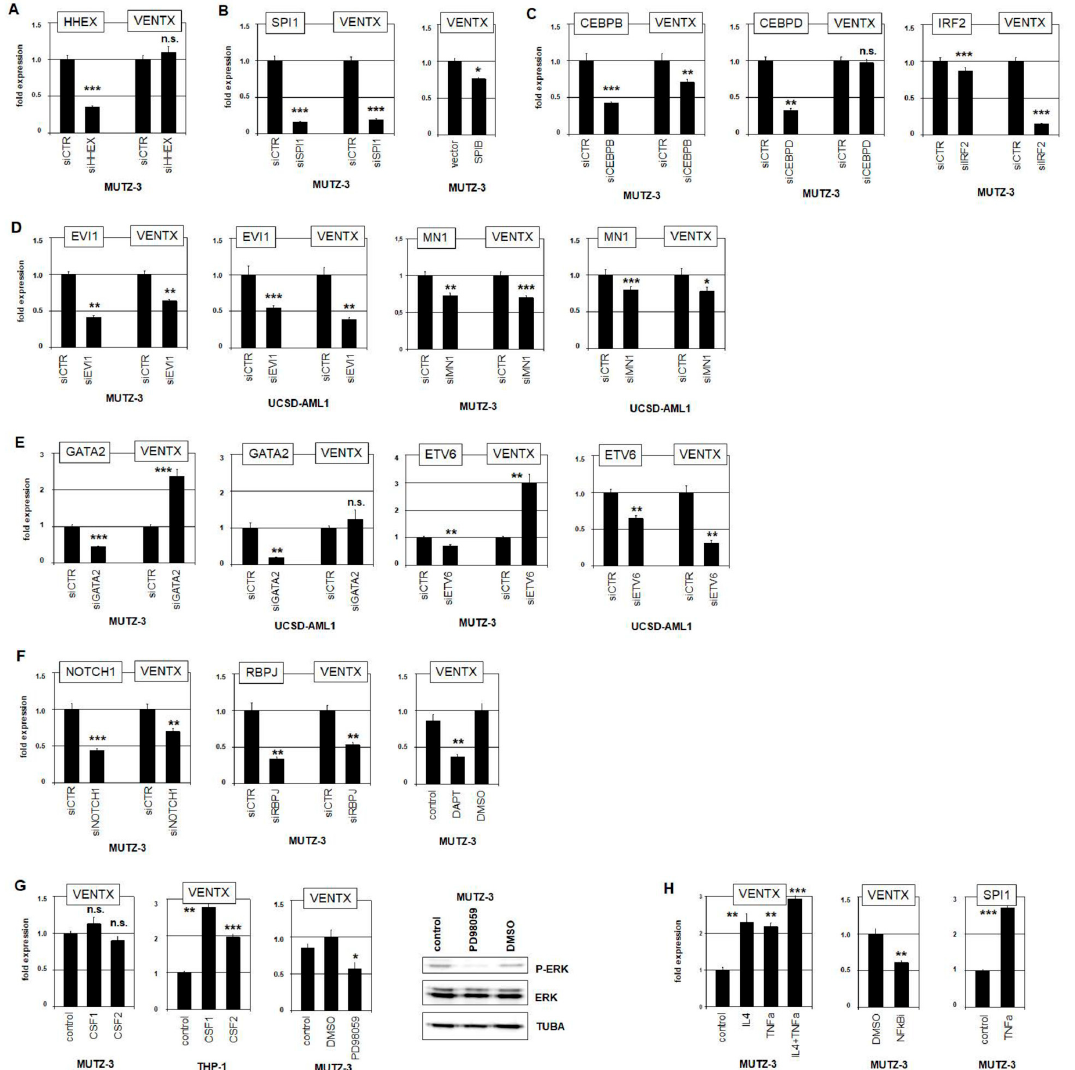
Figure 5. Evaluation of VENTX regulators. To evaluate identified candidate regulators of VENTX, we performed siRNA- mediated knockdown experiments and subsequent RQ-PCR analyses in MUTZ-3 and UCSD-AML1 cells. ( A ) Knockdown of HHEX showed no effect on VENTX levels in MUTZ-3. ( B ) Knockdown of SPI1 (left) and forced expression of SPIB (right) in MUTZ-3 resulted in reduced VENTX expression, indicating that SPI1 activated while SPIB repressed VENTX. ( C ) Knockdown of CEBPB and IRF2 resulted in reduced VENTX expression, indicating that both TFs activate VENTX in MUTZ-3. Knockdown of CEBPD (middle) showed no effect on VENTX expression. ( D ) Knockdown of EVI1 (left) and of MN1 (right) in MUTZ-3 and UCSD-AML1 resulted in reduced VENTX expression levels, indicating an activatory input of these factors in both cell lines. ( E ) Knockdown of GATA2 (left) and of ETV6 (right) in MUTZ-3 and UCSD-AML1 resulted in elevated VENTX expression levels in MUTZ-3 only. In UCSD-AML1, no effect or elevated VENTX levels were detected. ( F ) Knockdown of NOTCH (left) and of RBPJ (middle) resulted in reduced VENTX expression levels. Treatment of MUTZ- 3 cells with NOTCH-inhibitor DAPT also resulted in reduced VENTX expression, supporting that NOTCH1-signaling activated VENTX expression in MUTZ-3. ( G ) Stimulation with CSF1 or CSF2 showed no significant effect on VENTX expression levels in MUTZ-3 cells (left) while THP-1 cells showed increasing VENTX levels (middle left). Treatment of MUTZ-3 cells with ERK-inhibitor PD98059 resulted in reduced VENTX expression levels (middle right). Western blot analysis showed reduced levels of phosphorylated ERK protein after PD98059 treatment. ( H ) Stimulation of MUTZ-3 cells with TNFa and/or IL4 resulted in elevated VENTX transcript levels (left). Treatment of MUTZ-3 with NFkB-inhibitor caused reduced VENTX expression (middle). Stimulation of MUTZ-3 with TNFa resulted in elevated expression levels of SPI1 (right). The calculated p -values are indicated by asterisks (* p < 0.05, ** p < 0.01, *** p < 0.001, n.s. not